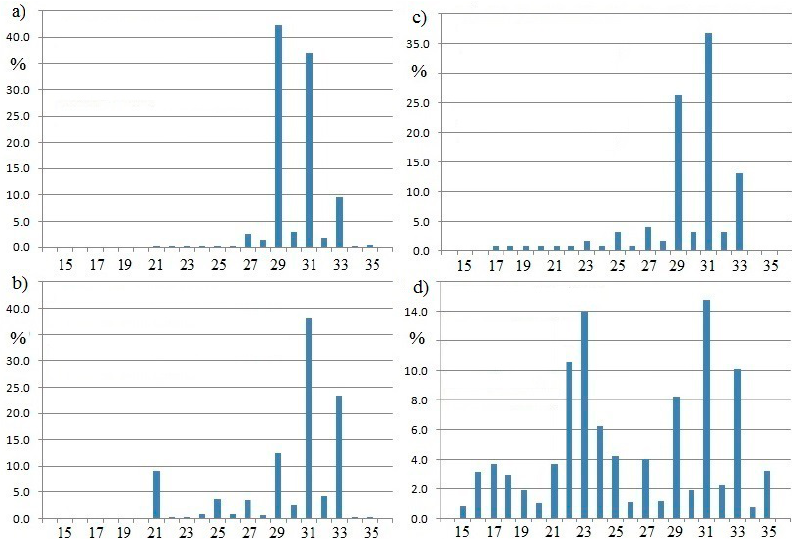
Figure 1. The typical percentage n-alkane content (nC 14 to nC 36 ) of soils from moist tropical forests obtained using solvent extraction and analyzed by gas chromatography—mass spectrometry. ( a ) The average n-alkane content of 184 tree leaf samples from tropical lowland forest, Peru. Drawn from tabulated data [20]. ( b ) The average n-alkane content of leaves from seven tree species, Brazil. Drawn from tabulated data [21]. ( c ) The n-alkane content of a moist tropical forest near the coast at Debu, Cameroon. Drawn from tabulated data [22]. ( d ) The n-alkane content of five soil samples from moist tropical forest, Nepal. Drawn from tabulated data [23].